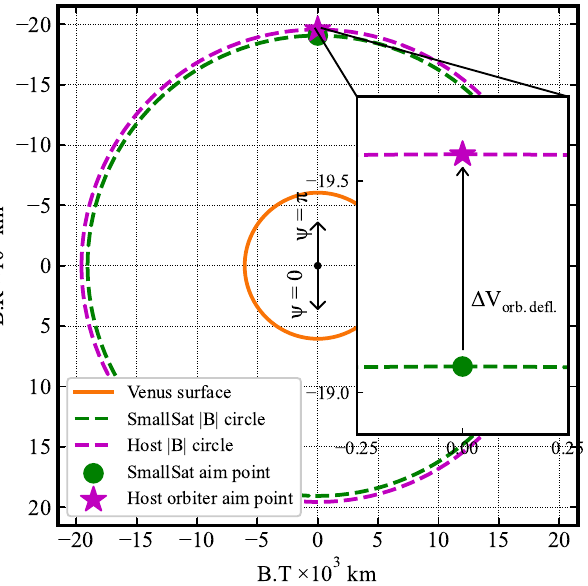
Figure 23. Small satellite and host orbiter aim points on the Venus B-plane. The inset shows a magnified view of the two aim points, both of which have ψ = π